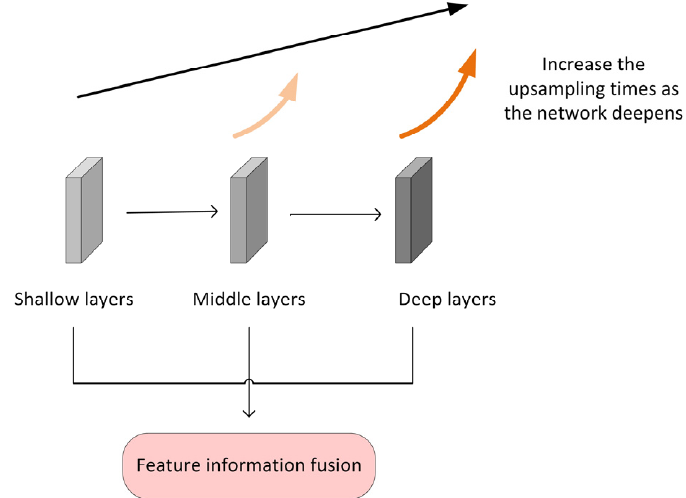
Figure 5. Schematic of the MFF module. With the deepening of the network, the upsampling times are increased to maintain the high resolution of image features.